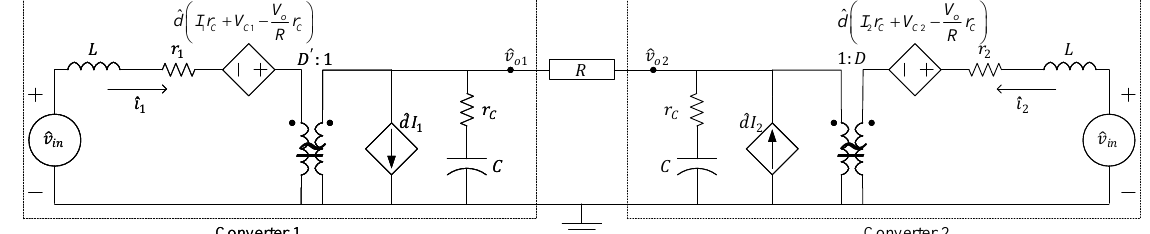
Figure 7. The AC equivalent model of the boost inverter.